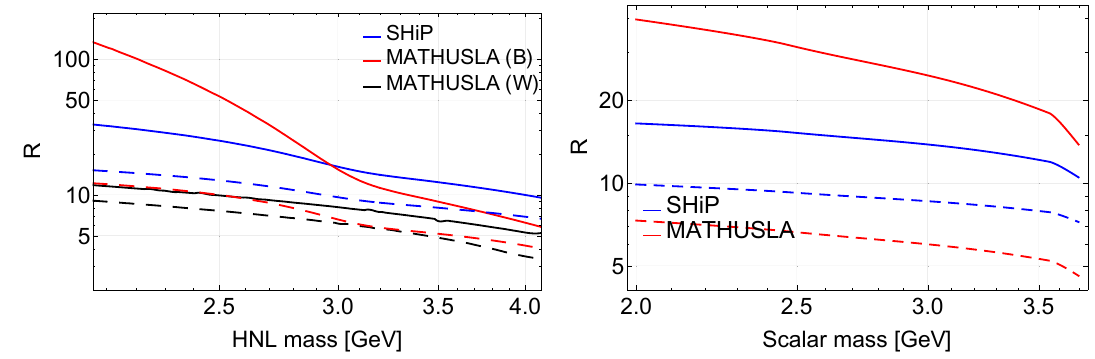
Figure 8 . Ratios R = θ 2 for the HNLs mixing with ν (left) and for scalars (right) at /θ 2 e upper max SHiP and MATHUSLA experiments. Solid lines are obtained by taking the account the energy distribution of the mother particles ( B mesons and W bosons). Dashed lines are obtained under an assumption that all particles have the same average